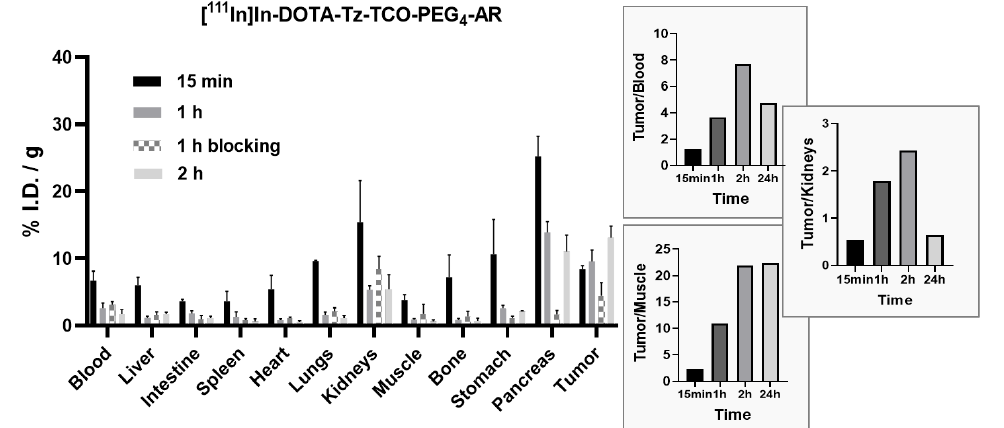
Figure 6. Biodistribution data of [ 111 In]In-DOTA-Tz-TCO-PEG 4 -AR (including tumor/nontarget organs ratios in the insert) in PC3 xenografts-bearing mice, expressed as %I.D./g of organ (mean ± SD, n = 3).